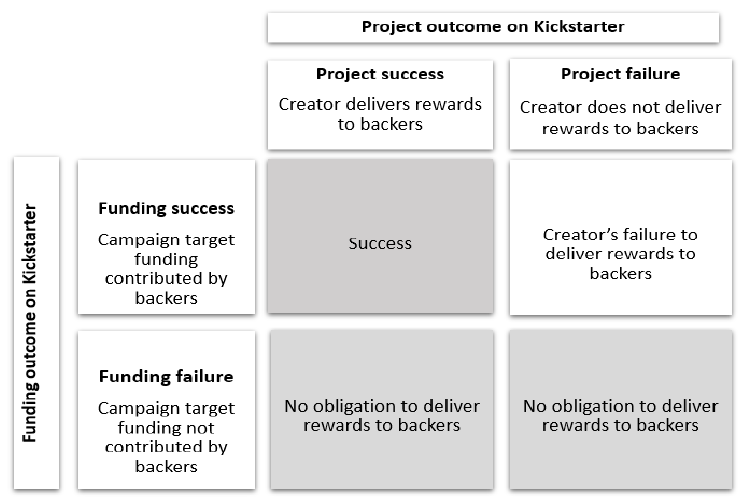
Figure 2. An overview of project and funding outcomes on Kickstarter.